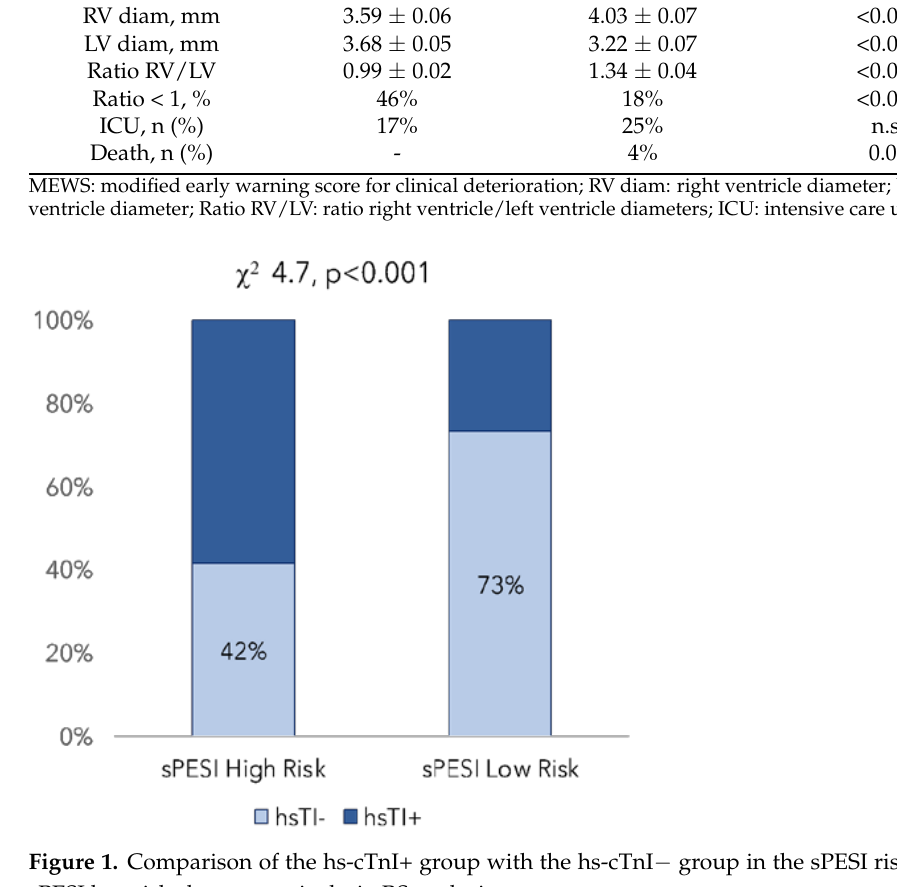
Table 2. Comparison of the hs-cTnI+ group with the hs-cTnI − group in RS analysis. HS-TnI − HS-TnI+ 1w-ANOVA Number of patients